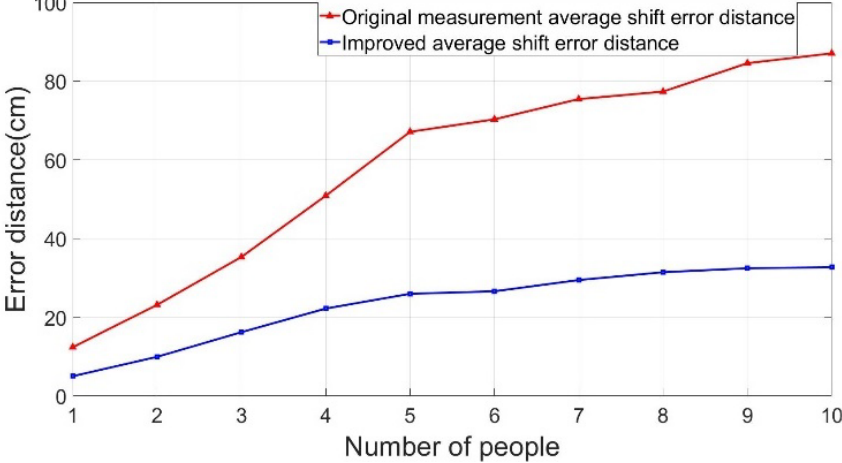
Figure 11. The average shift error distance (ASED) analysis diagram of people interference.